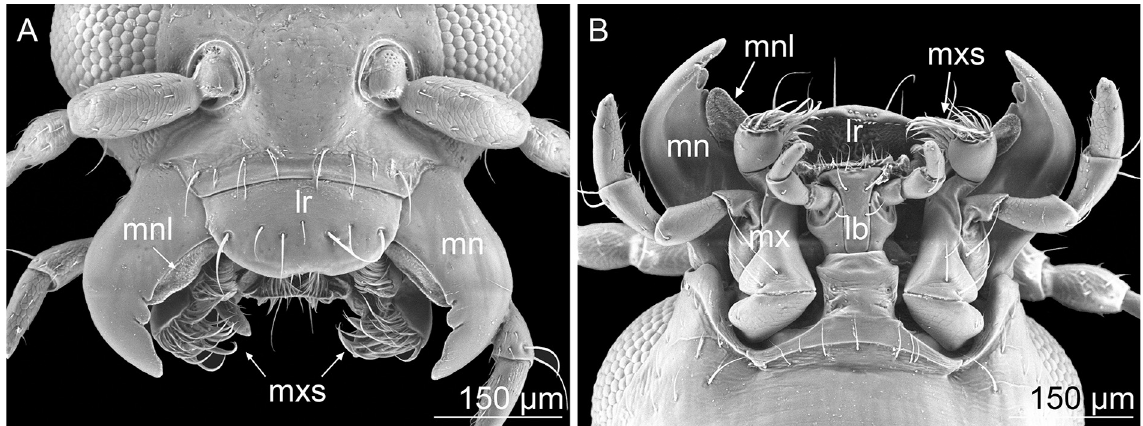
Fig. 7. Mouthparts of A. shirleyae Samuelson, 1973, Mt Koghi. A . Dorsal view. B . Ventral view. Abbreviations: lb = labium; lr = labrum; mn = mandible; mnl = mandibular lobe; mx = maxilla; mxs = maxillary